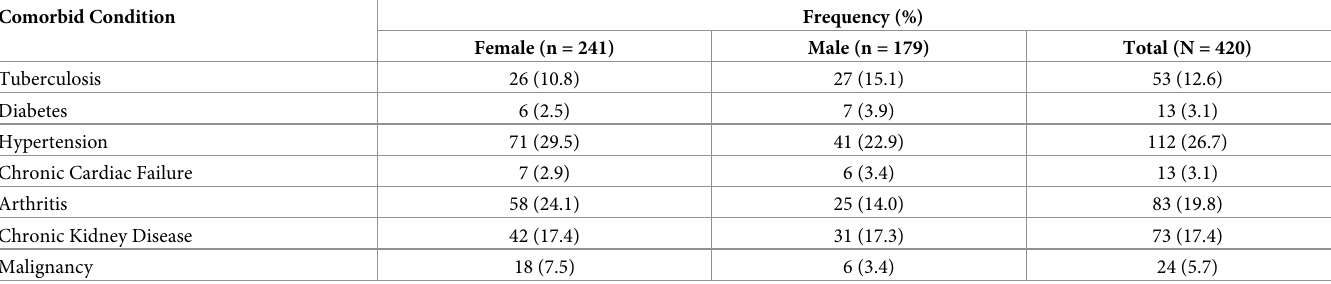
receiving additional chronic disease medicines compared to males (49.7%) (p = 0.002). Sixty- Table 3. Incident comorbidities among older patients receiving ART at Newlands Clinic (2004–2020). Comorbid